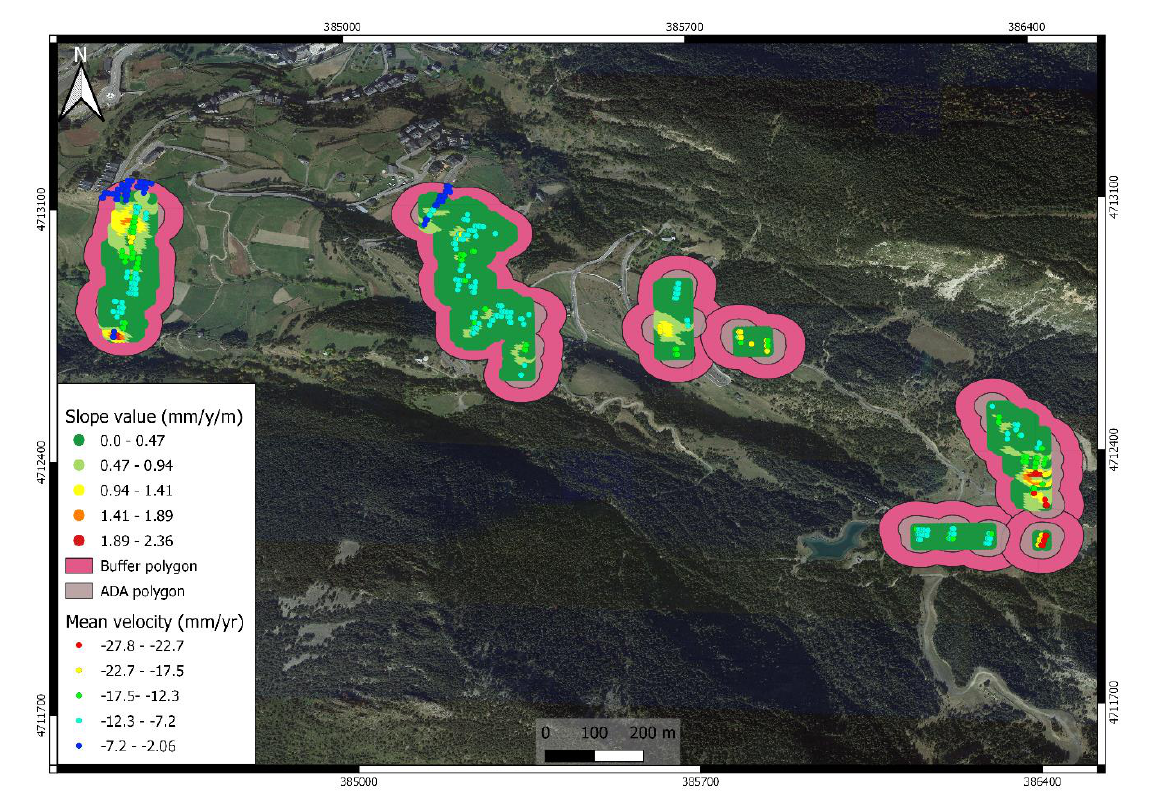
Figure 3. A Terrain Differential Deformation Map with Averaging filter in rural areas. Slope values are from 0 to 2.36 (mm/yr/mm). Dark and light pink polygons show the Buffer and ADA polygons,